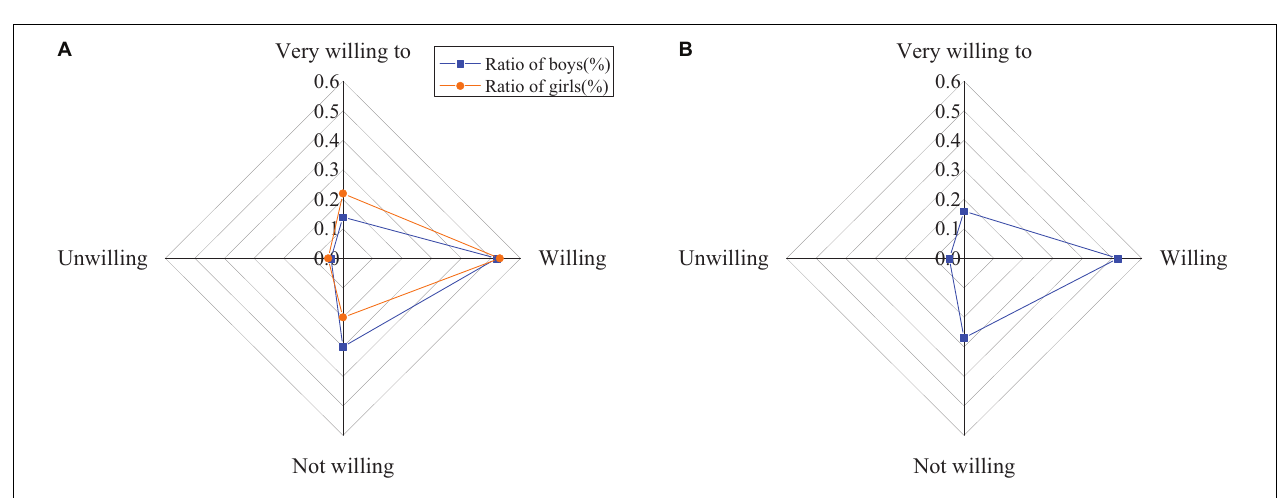
FIGURE 13 | Willingness of college students to participate in psychological education [ (A) the ratio of the males and females; (B) the ratio of all].